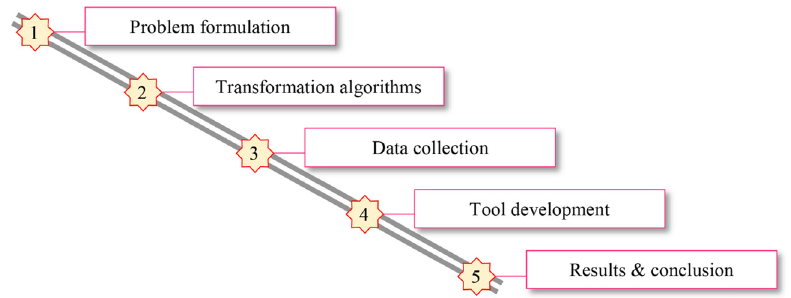
Figure 3: Graphical depiction of the research methodology.